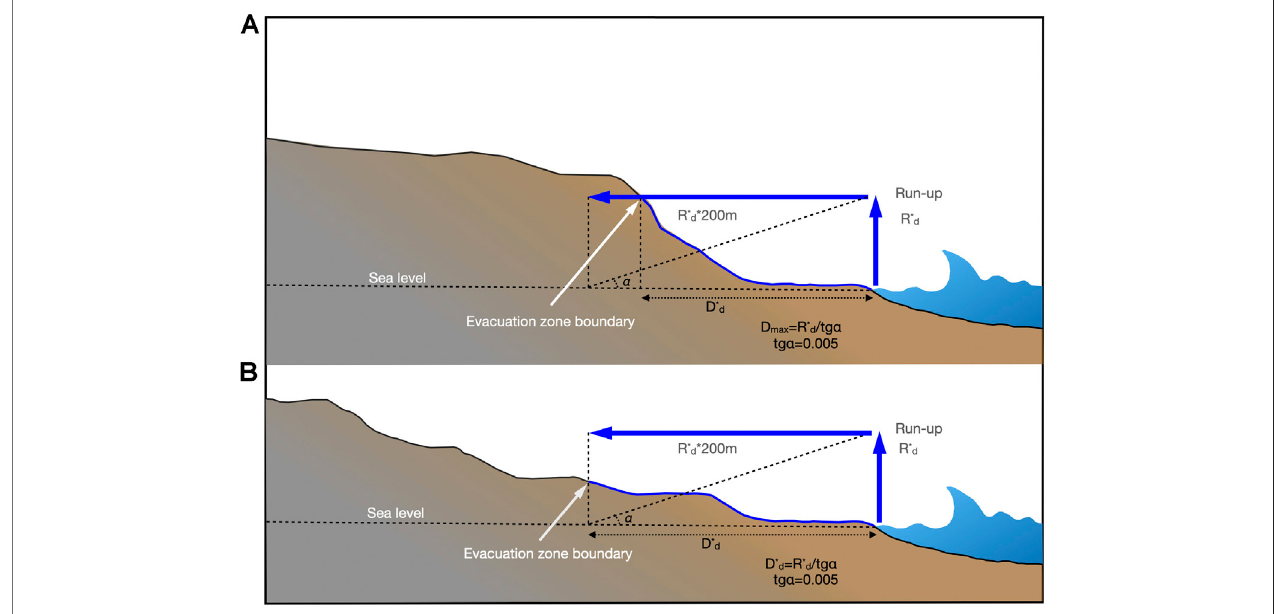
FIGURE 4 | Sketch of the method used to drawn inundation maps: R p d is the maximum estimated run-up value for a given stretch of coast, D p d is the inundation distanceand,intheexample,thedissipationfactor istg α (cid:1) 0.005(norivers). Thecartoonillustratesthetwodifferentbehaviourswhen R p d crossesthetopographybefore than the projected ray on the sea level (panel A ) or vice versa (panel B ).